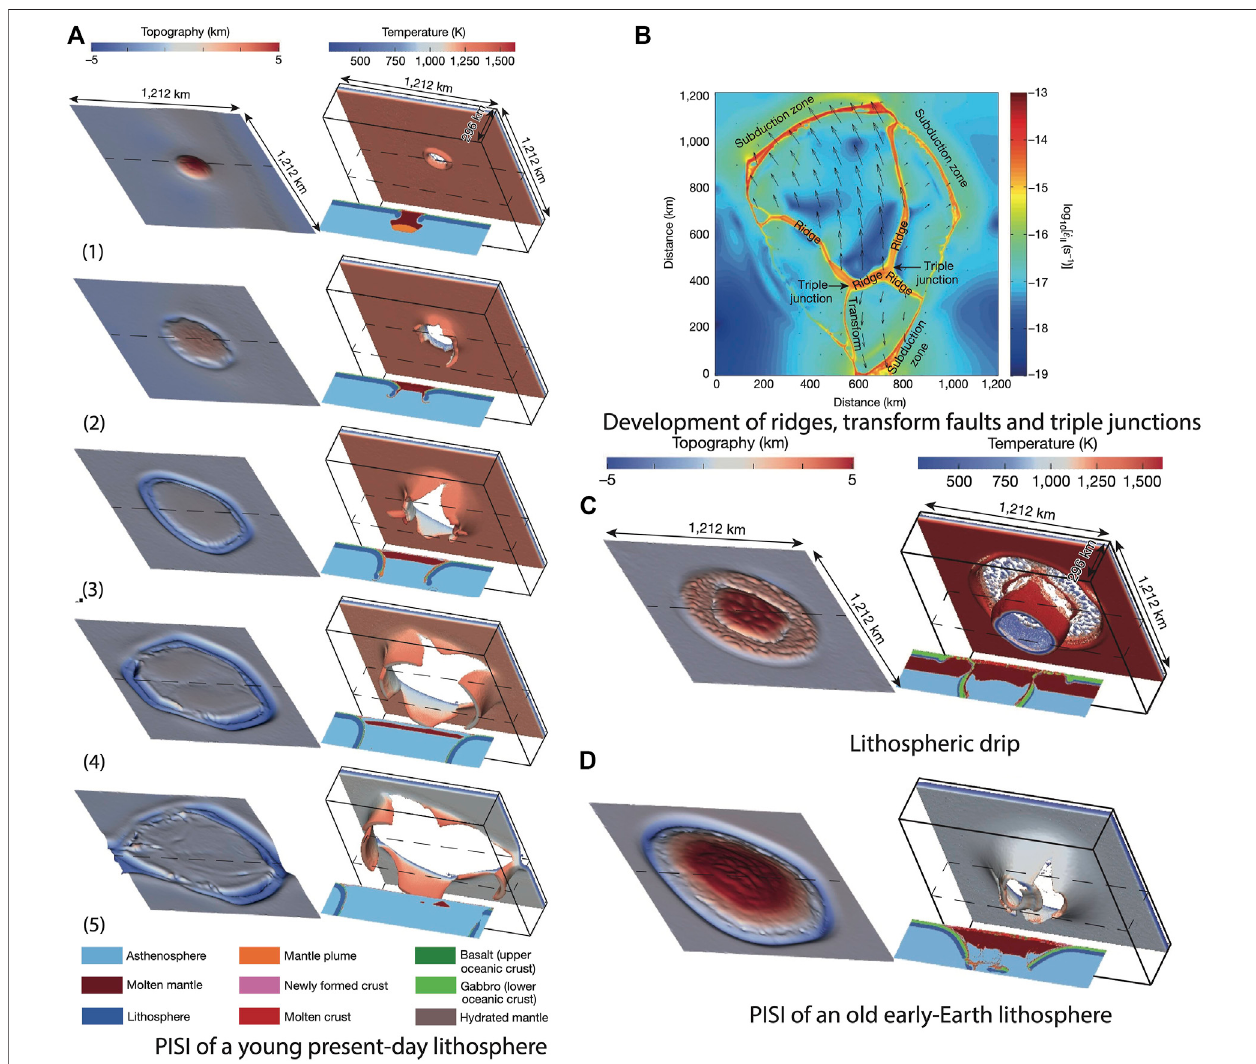
FIGURE6| ModelingresultsofGeryaetal.(2015). (A) Modelevolutionofplume-inducedsubductioninitiationunderpresent-daymantletemperature conditions. (1) Oceanicplateaudevelopment, (2) formationofanincipienttrenchandanearlycylindricalslab, (3) tearingofthecylindricalslab, (4) formationofretreatingsubduction zones and (5) development of spreading centres and transform boundaries. Left and right columns show topography and subducted lithosphere morphology with projected slab surface temperature, respectively. Dashed lines indicate positions of the 2D cross-sections (colour code is at the bottom of the fi gure). (B) Spatial distribution of second strain rate invariant at a depth of 20 km, illustrating formation of a mosaic of plates separated by spreading centres (ridges), triple junctions and transform faults at the latest stage of plume-induced subduction. Arrows show horizontal velocities of individual, young, non-subducting plates moving towards retreating subducting slabs. (C,D) Plume – lithosphere interaction for hotter mantle and thicker oceanic crust – indicating early-Earth conditions-for: (C) a 20-Myr-old oceanic plate and (D) a 80-Myr-old oceanic plate. Description of panels are similar to (A) (from Gerya et al., 2015).